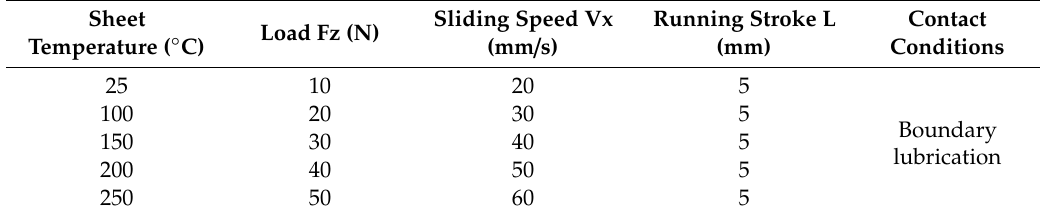
Table 2. Parameter settings of 6111 aluminum alloy for the friction